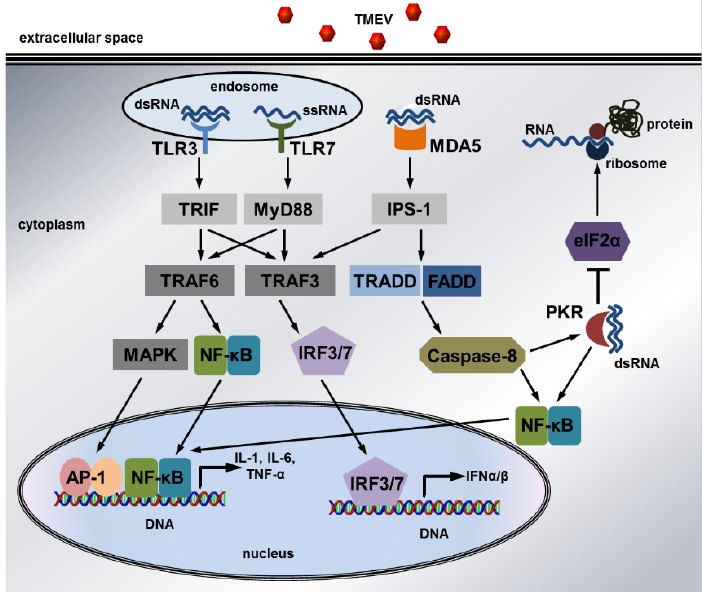
Figure 6. The intracellular signaling pathways induced by Theiler’s murine encephalomyelitis virus: Detection of dsRNA by TLR3 and ssRNA by TLR7 in endosomes leads to the recruitment of TRIF and MyD88, which interact with TRAF3 and TRAF6 to trigger MAPK, NF- κ B, and IRF signaling. This results in transcription of the pro-inflammatory cytokines IL1, IL6, and TNF α as well as antiviral IFN α / β . Viral dsRNA in the cytoplasm is recognized by MDA5, which activates IPS-1 to initiate IRF signaling via TRAF3. Moreover, MDA5 triggers NF- κ B signaling via TRADD and FADD as well as caspase-8. NF- κ B signaling can also be induced by PKR, which is activated by binding to cytoplasmic dsRNA. In addition, PKR phosphorylates eIF2 α to inhibit mRNA and viral RNA translation and thus virus replication. Finally, caspase-8 can cleave the inhibitory N-terminus of PKR to activate this antiviral protein, whose expression is stimulated by IFN α / β . Only selected pathway members are shown due to simplification. Solid arrows indicate activation while “T” indicates